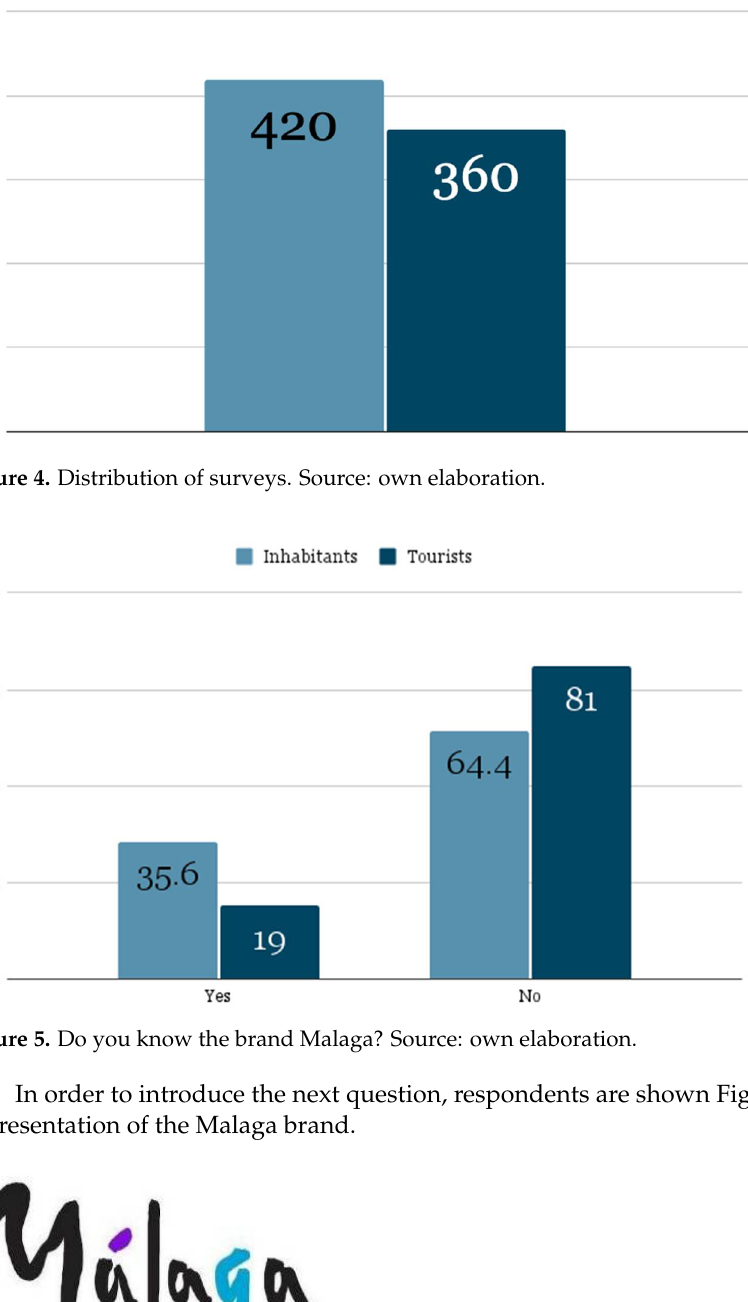
Figure 5. Do you know the brand Malaga? Source: own elaboration.